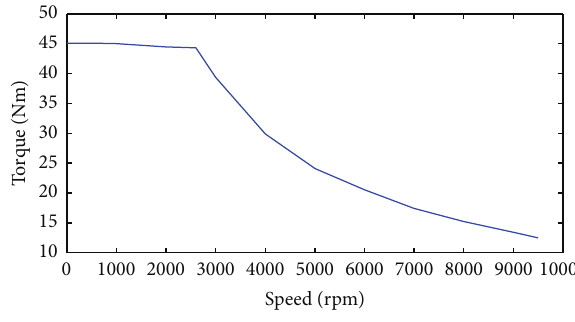
Figure 3: The peak torque versus motor speed curve.